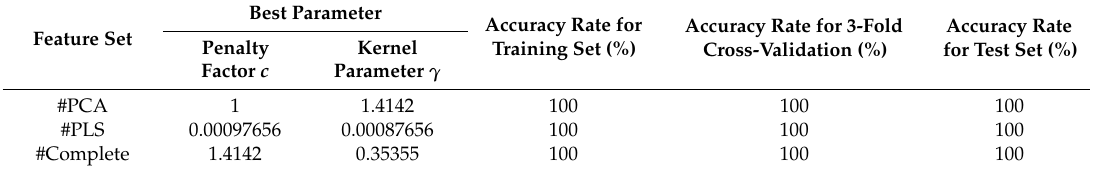
Figure 5. The Grid Search for the best parameter for constructing the LIBSVM model: ( a ) Based on the PCA-optimized feature set; ( b ) Based on the PLS-optimized feature set; ( c ) Based on the original feature set. Table 2. Comparison of classification results of #PCA, #PLS and #Complete combined with SVM model. Feature